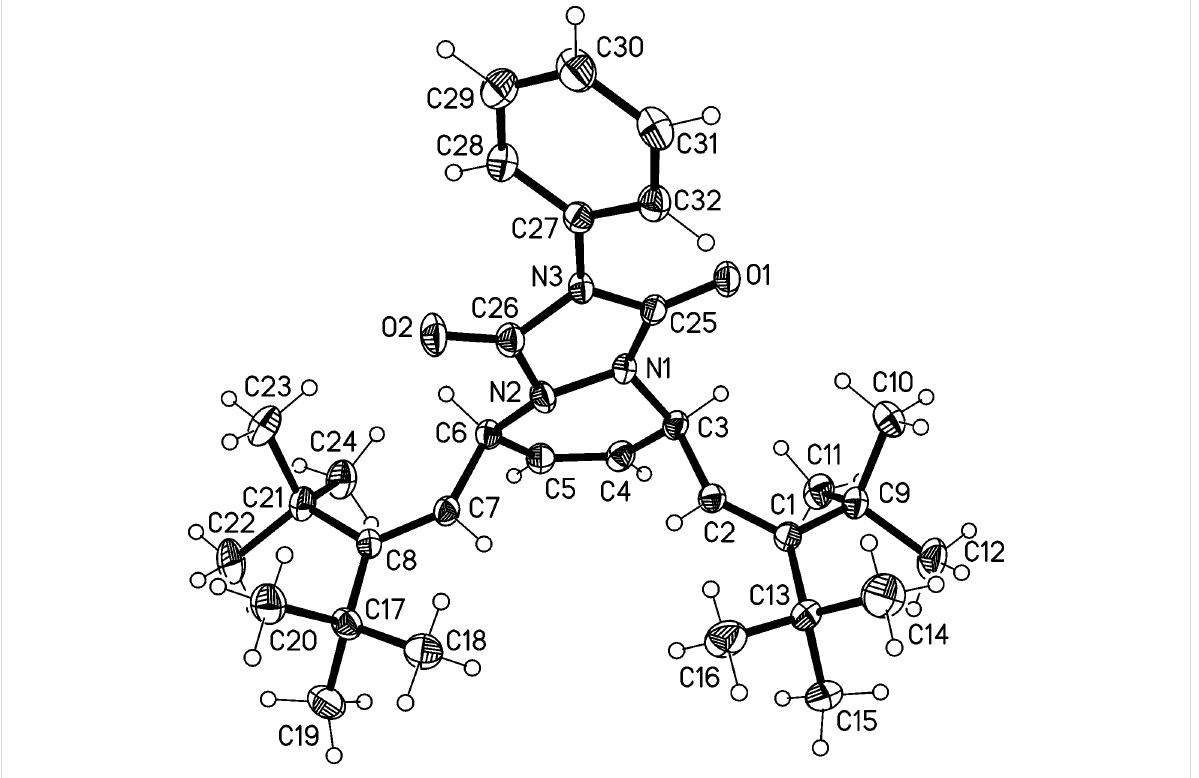
Figure 4: The structure of compound 37 in the crystal. Only one of two independent molecules is shown. Ellipsoids correspond to 30% probability levels.